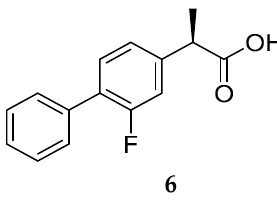
Figure 8. Tarenflurbil (R-flurbiprofen) ( 6 ).